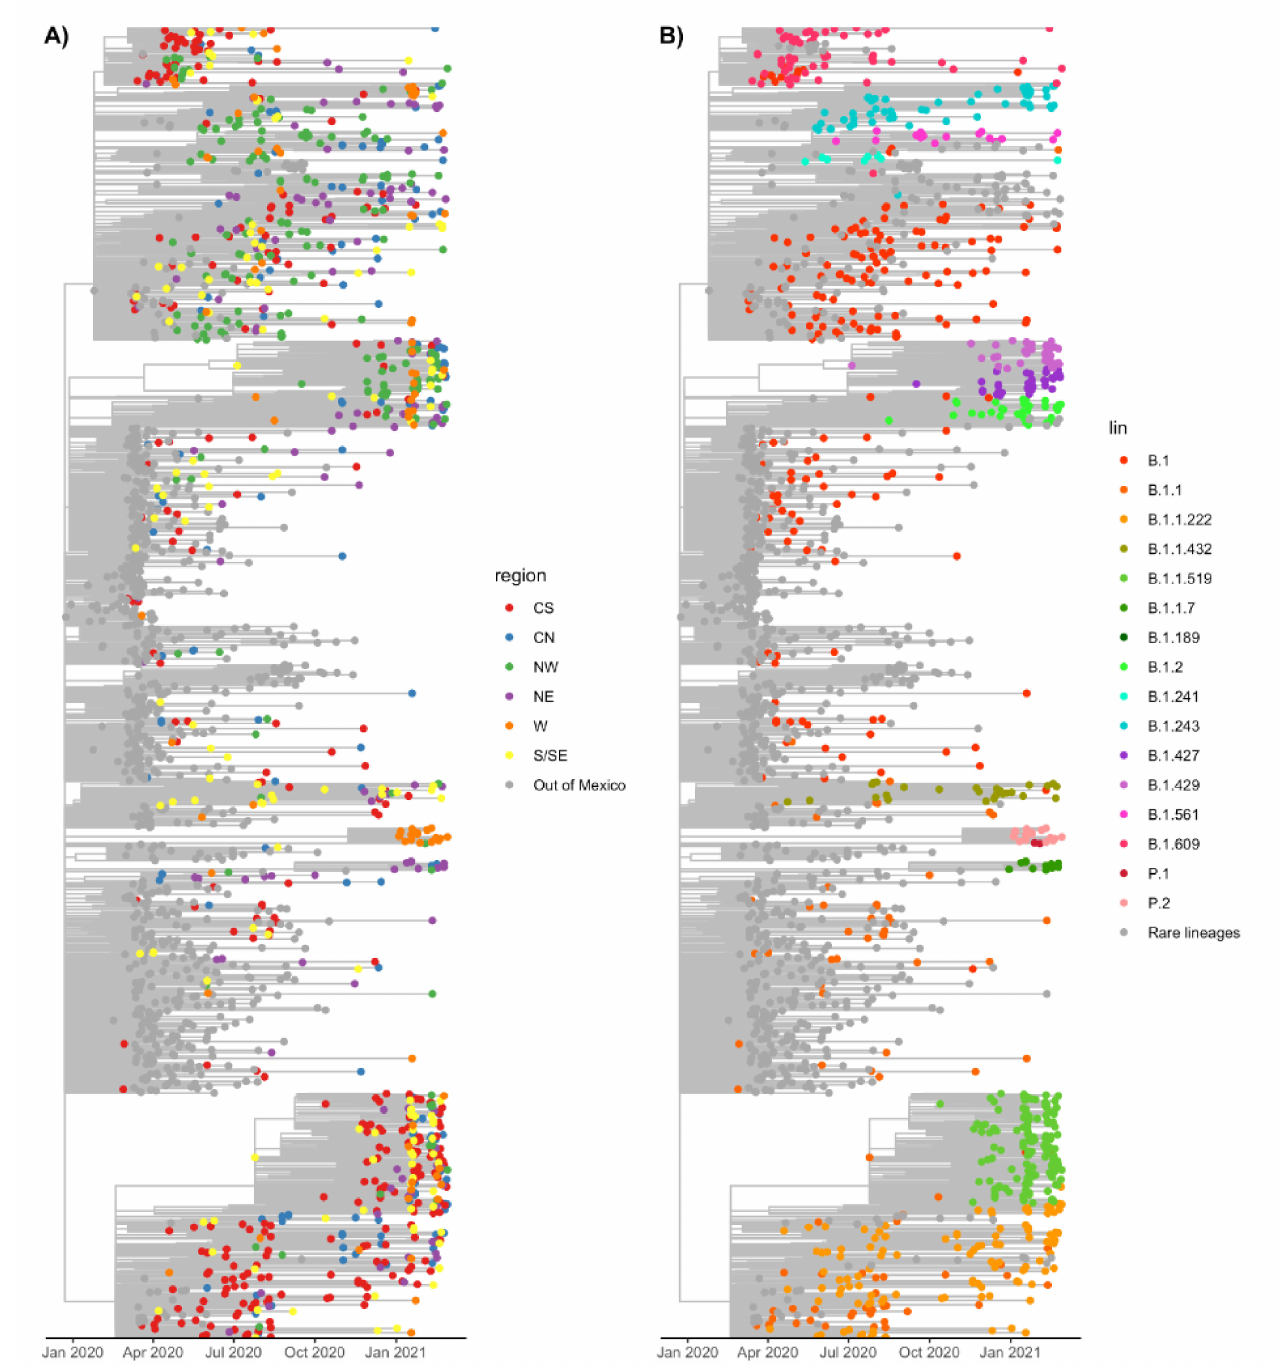
Figure 5. Maximum likelihood time-scaled phylogeny of Mexican and reference sequences. ( A ) The tips are colored by geographical region, while worldwide sequences are shown in grey. ( B ) Tips are colored by lineage. Lineages present in less than 1% of the sequences that do not correspond to VOC or VOM are shown in